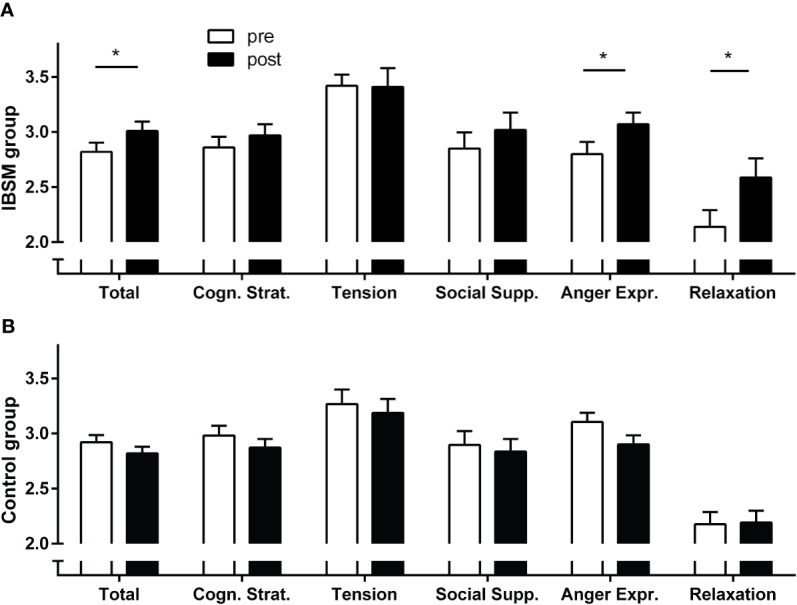
Pre-post training stress coping abilities measured with the ISBF (A) in the Internet-Based Stress Management (IBSM) group and (B) in the control group. Bars represent mean ± s.e.; *p < 0.05.